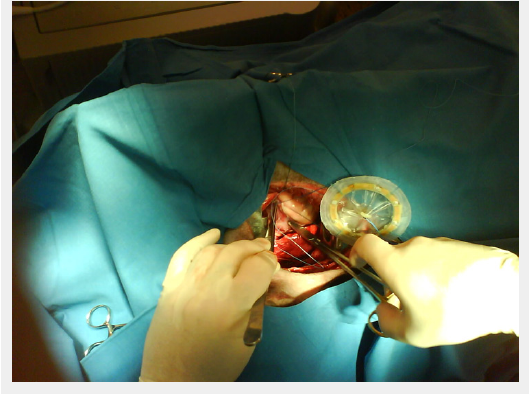
The above curves illustrate the extension relationship of a muscle that is stretched (left) and an SMA spring actuator (right) at different temperatures. The idea in this comparison is to identify a hysteresis loop in both cases. Left: typical stress–muscle length extension relationships, measured during 6 Cycles of 5, 10 and 15% length extension at 25 μm s−1. Right: isothermal force-displacement curves of an SMA spring actuator.